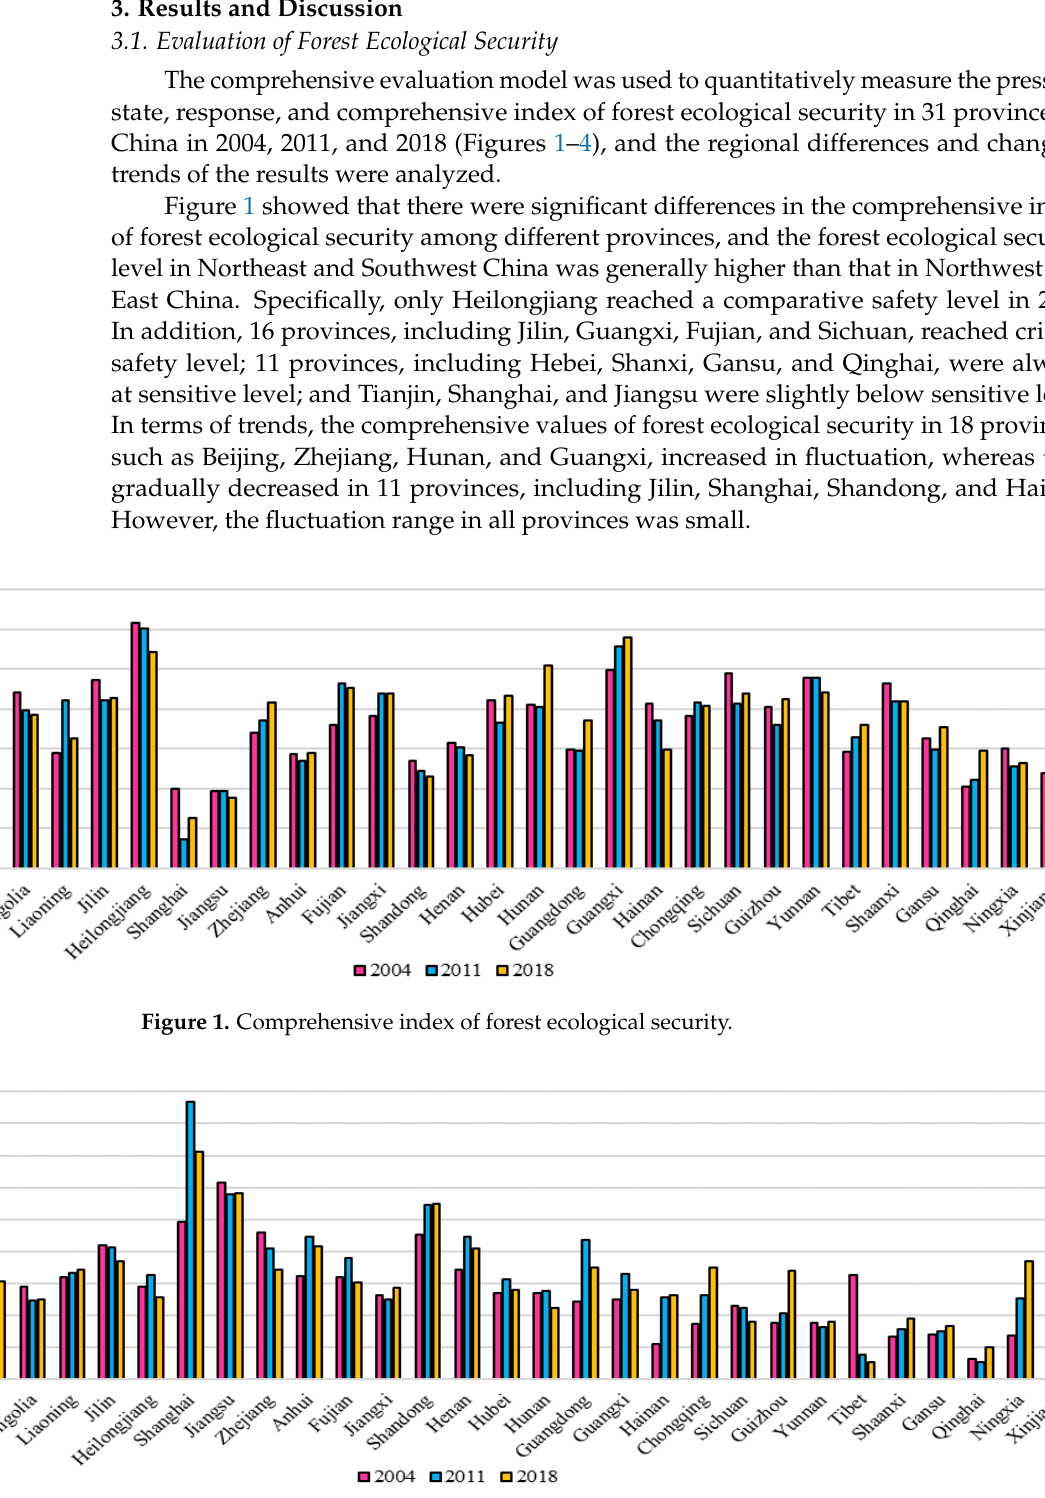
Figure 2. Pressure index of forest ecological security.